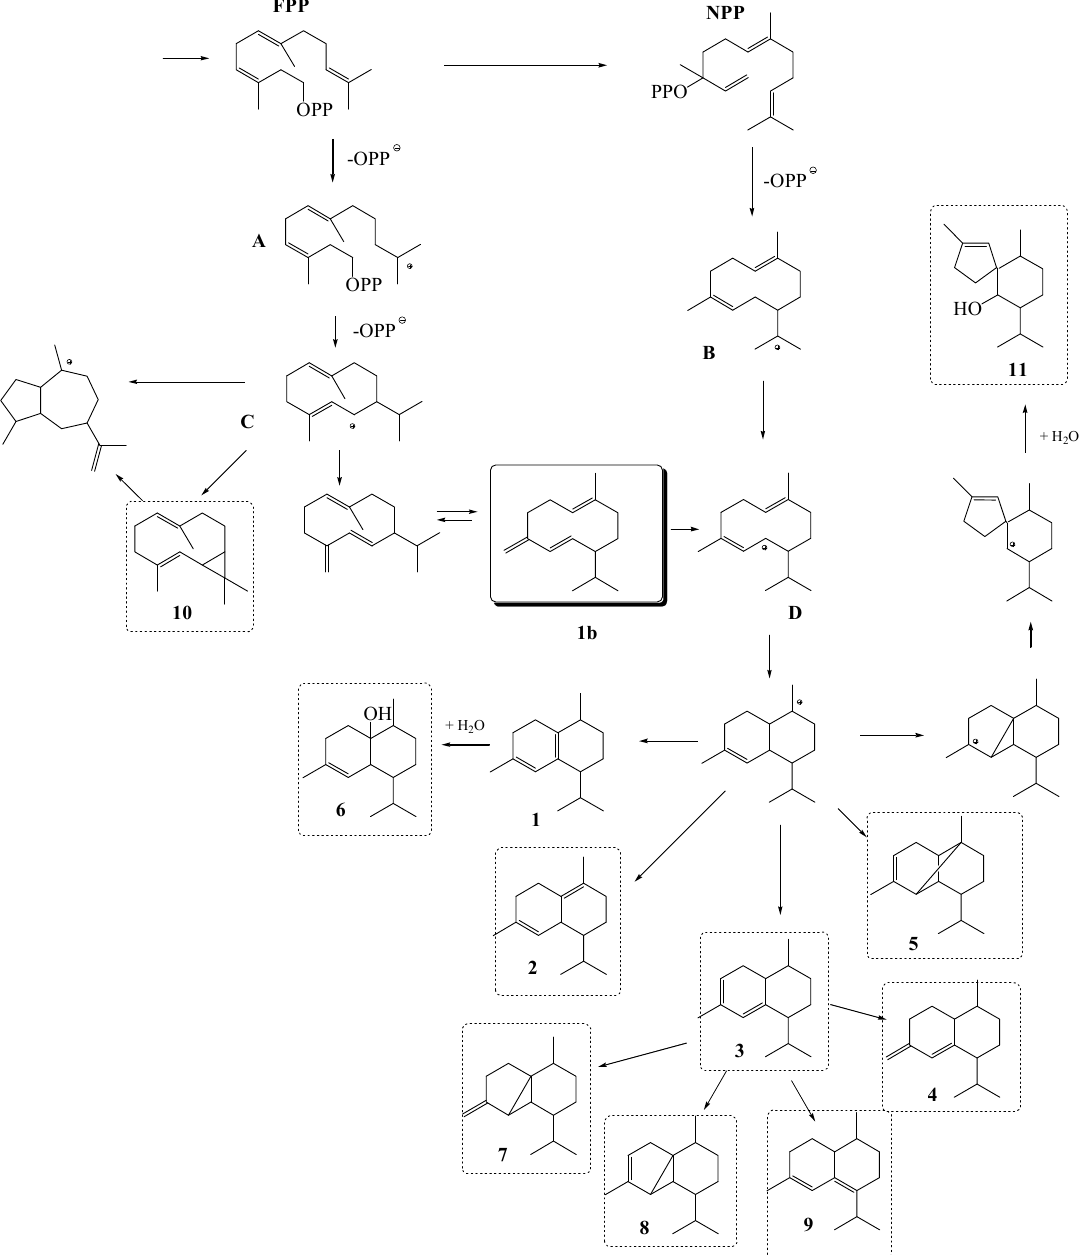
Figure 1. Possible biosynthetic correlations [37,38] among the main identified compounds in T. atomaria : FPP —farnesyl pyrophosphate; NPP —neryl pyrophosphate; germacreny cations ( A , B , C and D ); 1 : cadina ‐ 1(6),4 ‐ diene; 2 : δ‐ cadinene; 3 : cadina ‐ 3,5 ‐ diene; 4 : epi ‐ bicyclosesquiphellandrene; 5 : ylangene; 6 : cubebol; 7 : β‐ cubebene; 8 : α‐ cubebene; 9 : zonarene; 10 : bicyclogermacrene; 11 : gleenol; 1b : germacrene D.